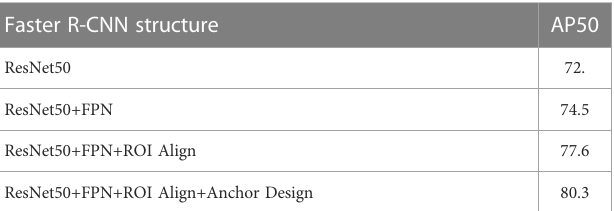
TABLE 2 Detection performance of different